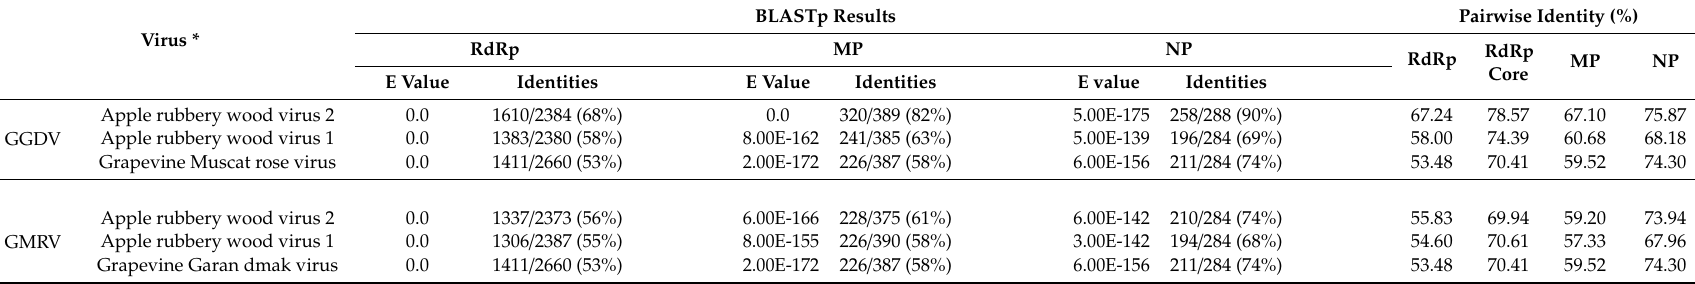
Table 1. Amino acid sequences identities between grapevine Muscat rose virus, grapevine Garan dmak virus, and apple rubbery wood viruses 1 and 2. Virus